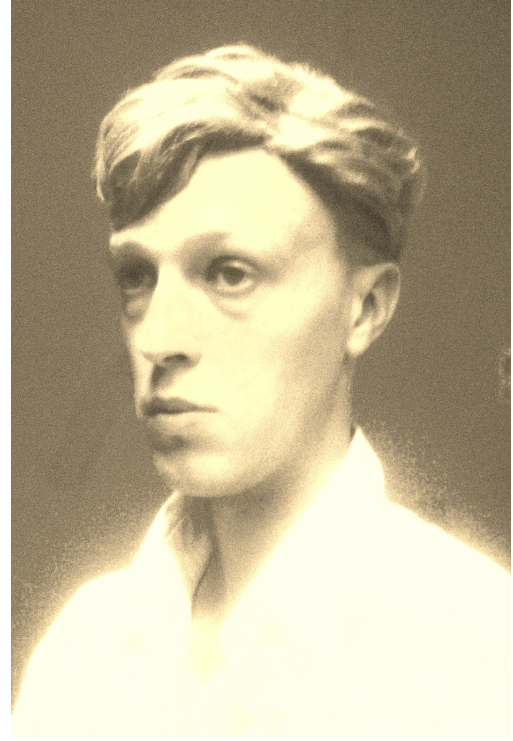
Figure 4: Christian